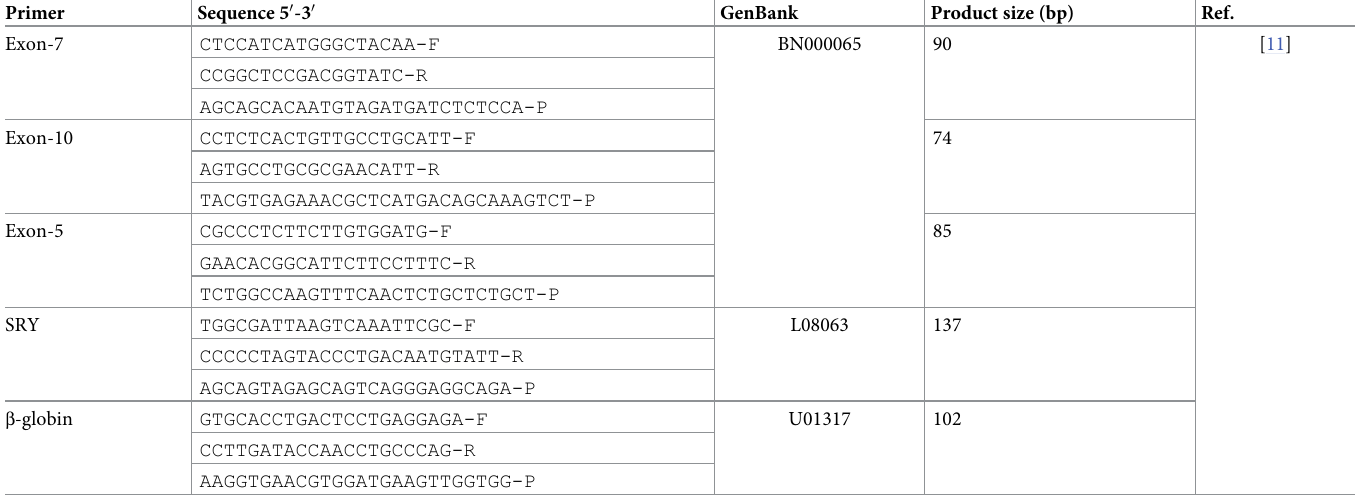
Table 1. Primer and probe characteristics used in the detection of fetal RhD status. Primer Sequence 5 0 -3 0 GenBank Product size (bp) Ref.